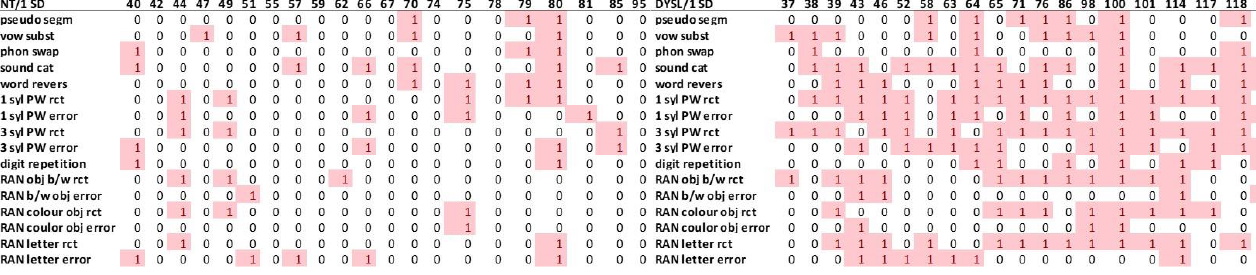
Figure 6. Deviating individual performance/indices. NT: neurotypical normal reading children, DYSL: children with dyslexia (numbers in the head row depict the individual subject), phon: pho- nological awareness, RAN: rapid automatized naming, PWM: phonological working memory, rct: reaction time, magno: magnocellular, parvo: parvocellular.